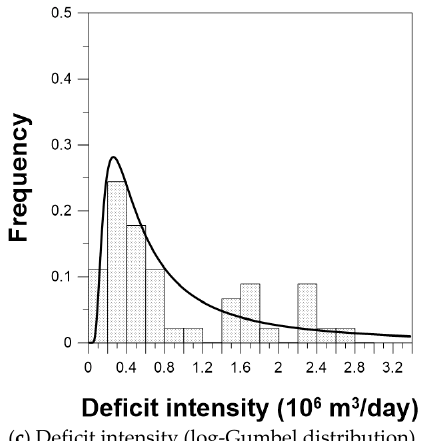
Figure 4. Comparison of data histograms and PDFs for three components of water deficit events observed at the Namgang dam.